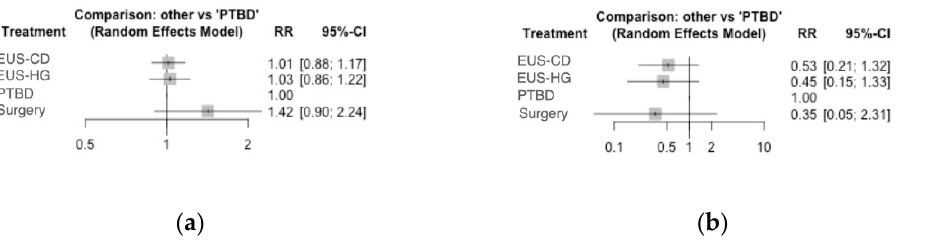
Figure 3. Forest plots of the network meta-analysis comparing different interventions to percutaneous trans-hepatic biliary drainage in terms of ( a ) clinical success rate and ( b ) adverse event rate. Similarly, the comparison between EUS-HG and EUS-CD was not significant